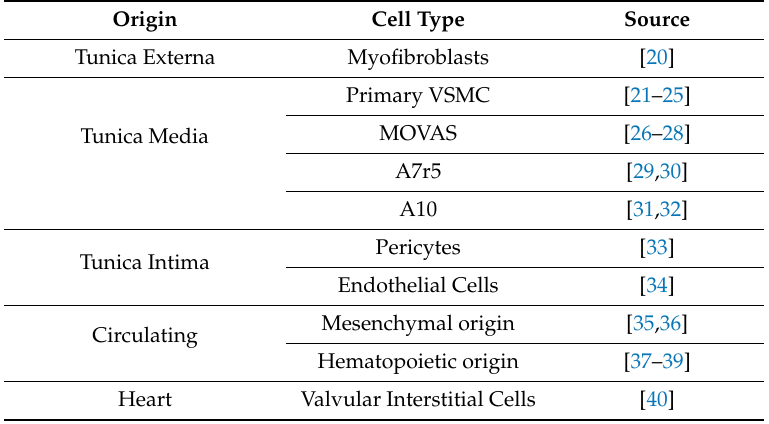
Table 1. Selected cell types for researching vascular calcification in